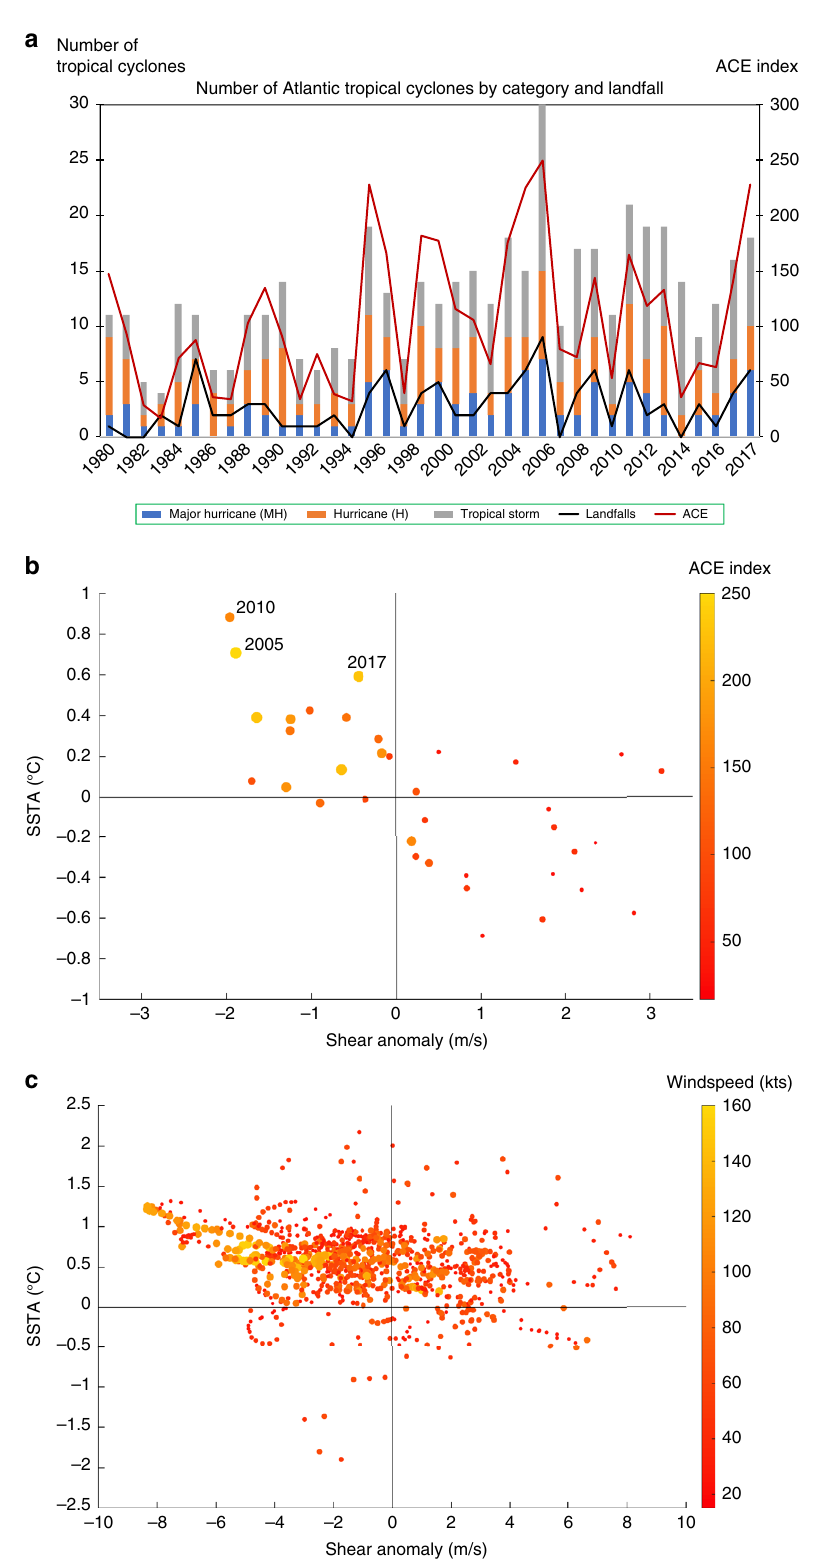
Fig. 1 Atlantic tropical cyclone analysis. a Observed Atlantic tropical cyclone activity and ACE index from 1980 – 2017. b SSTA and vertical wind shear anomalies in the MDR between July and September for the period 1980 – 2017 and associated ACE Index (point size and colourbar). c Six hourly data from August to September Atlantic tropical cyclone tracks for the years 2005, 2010 and 2017, detailing the SSTA (°C), vertical shear anomaly, and associated wind speed (point size and